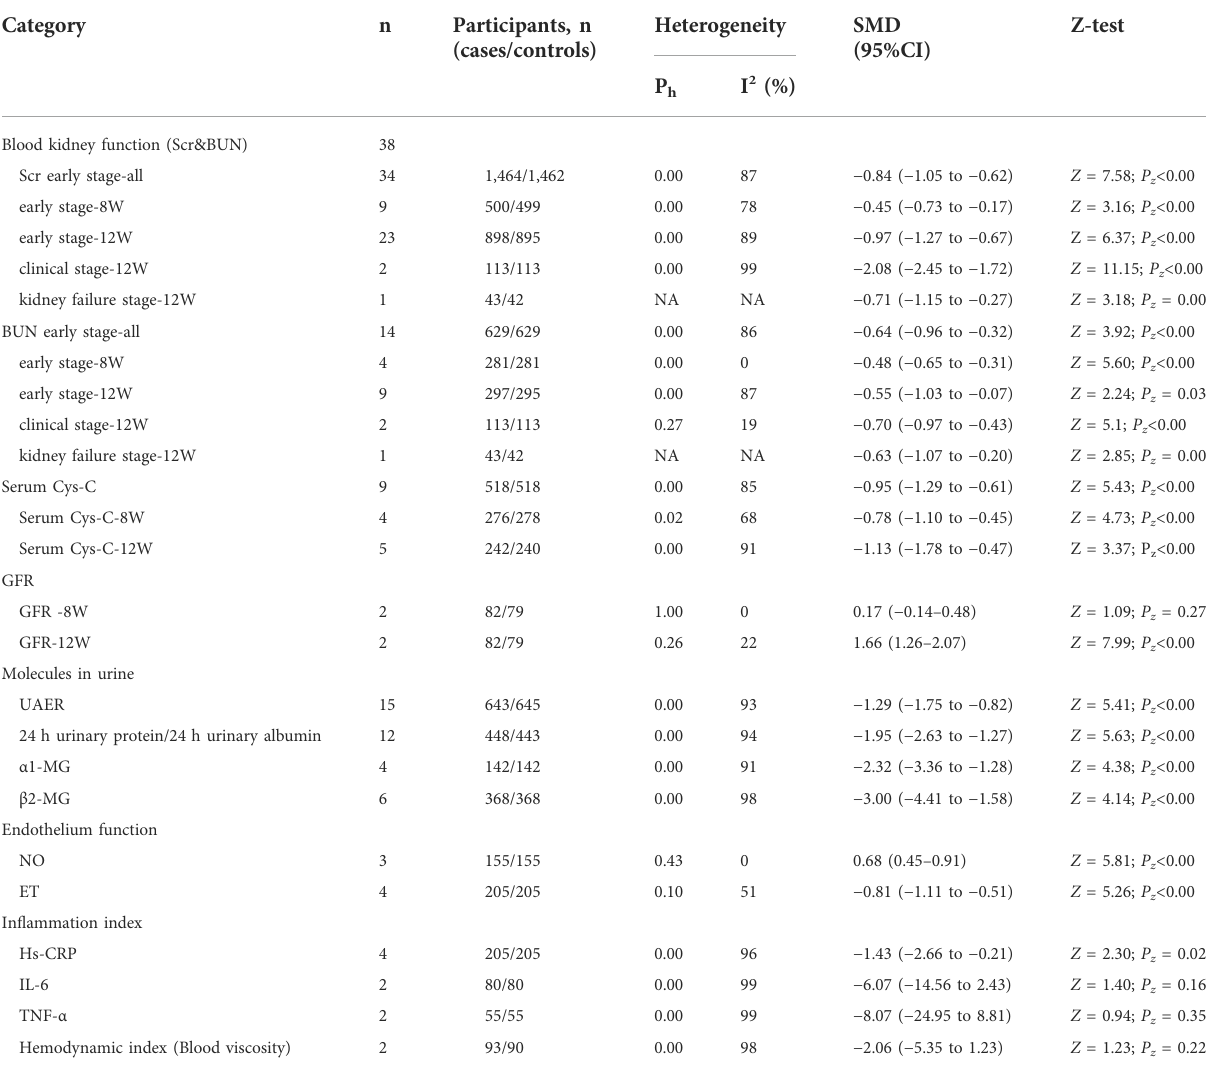
TABLE 1 Meta-analysis of the randomized controlled study of DKD patients ’ treatment with